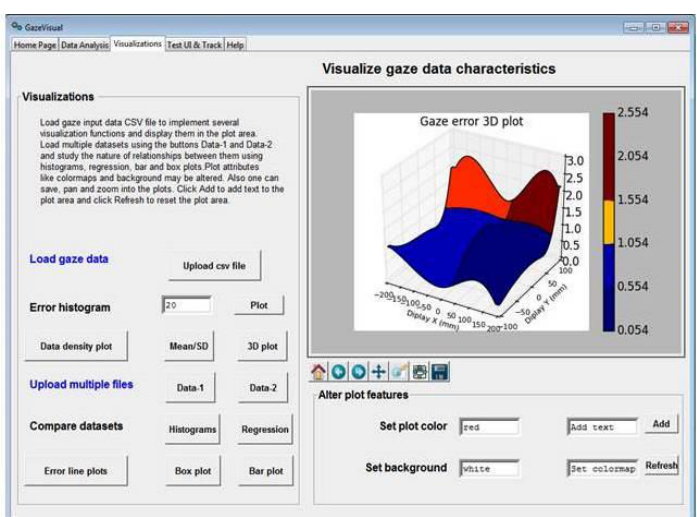
Figure 6. View of the “Data Analysis” window of the GazeVisual software.